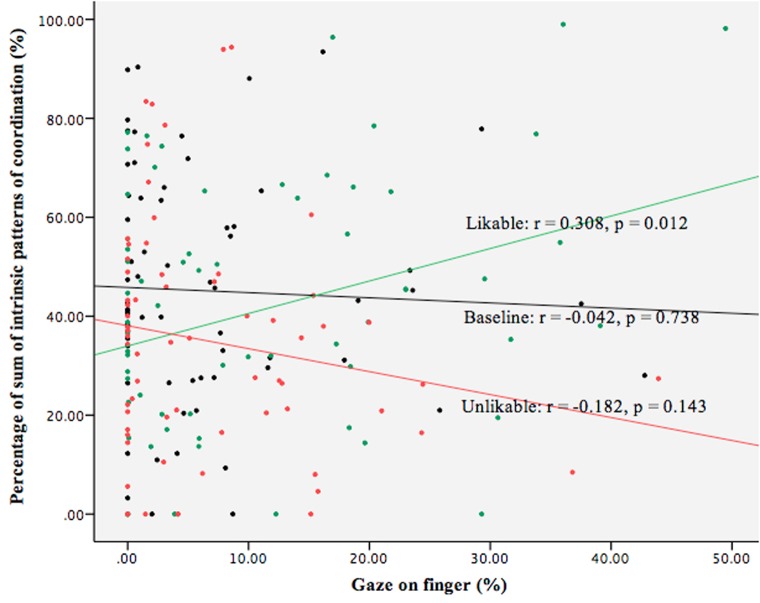
Scatter plot and linear correlation between interpersonal motor coordination (IMC) and gaze on finger in the 100% condition. For brevity, only the relation between the amount of gaze on finger and the occurrence of sum of in- and anti-phase coordination was plotted. Black dots: baseline; Green: likable; Red: unlikable.